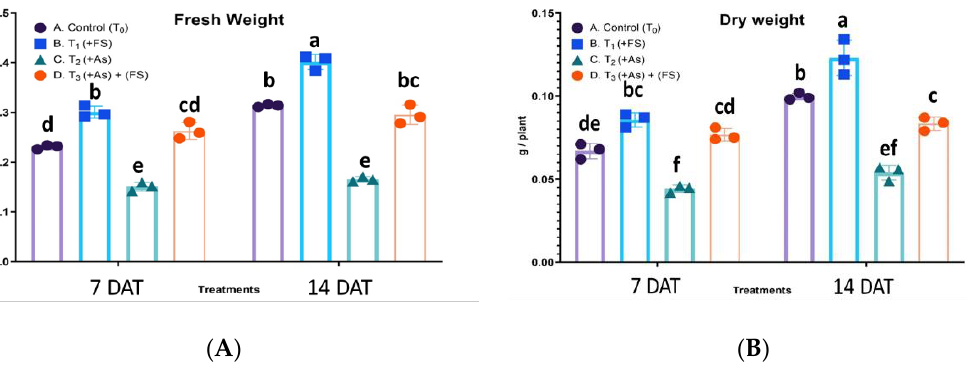
Figure 1. ( A , B ): Impact of iron sulfate (T 1 : +FeSO 4 ), arsenic stress (T 2 : +As) and FeSO 4 supplementation during As stress (T 3 : As+FeSO 4 ) on fresh ( A ) and dry ( B ) weights of Brassica juncea studied 7 and 14 days after treatment (DAT). The values are mean ± SE and n = 3. Different letters on the bars indicate significant changes ( p < 0.05) in different treatments as determined by Tukey’s HSD test. As, Arsenic; FS, FeSO 4 .